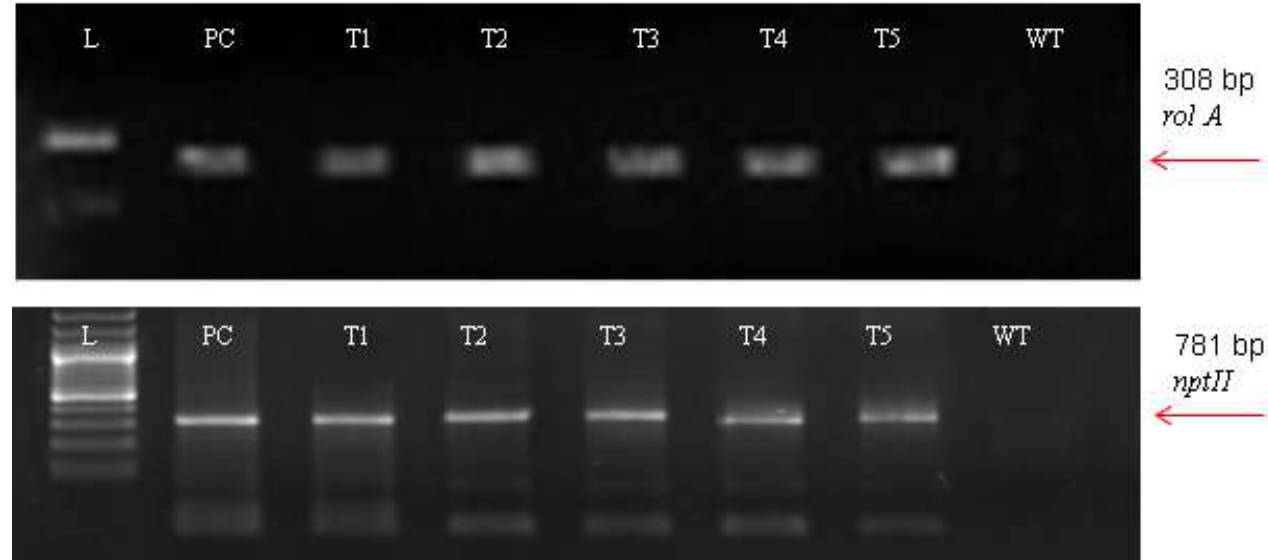
Figure 2. PCR result of transgenic Artemisia carvifolia harbouring rol A genes showing 308 bp for rol A and 781 bp for the nptII gene.